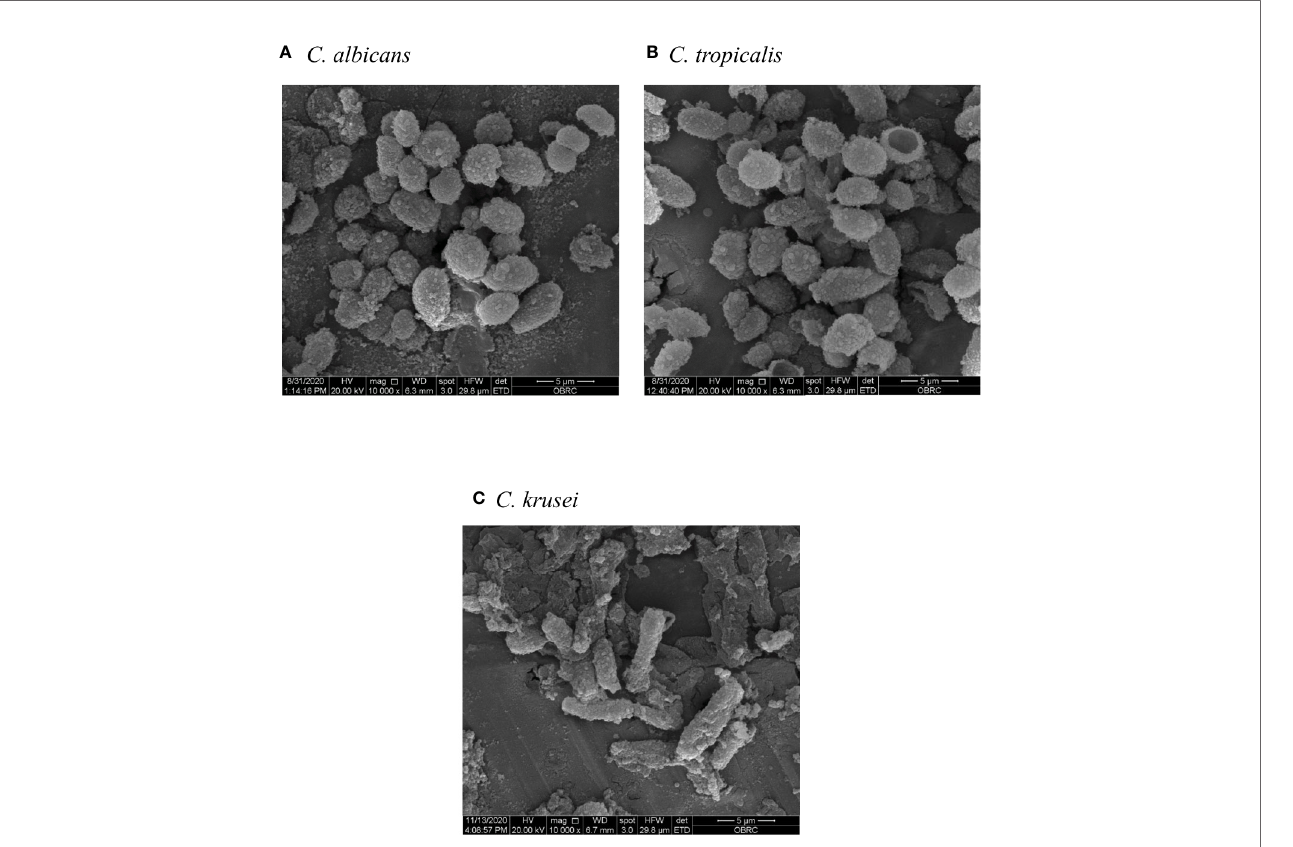
FIGURE 1 | Morphology and size of Candida b -glucans. b -glucans of (A) Candida albicans , (B) Candida tropicalis , and (C) Candida krusei were observed by scanning electron microscopy (SEM) with 10,000x magni fi